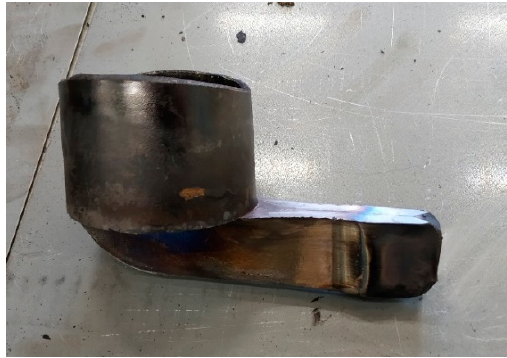
Figure 6. Obtained component after the first NSF trial with the 42CrMo4.